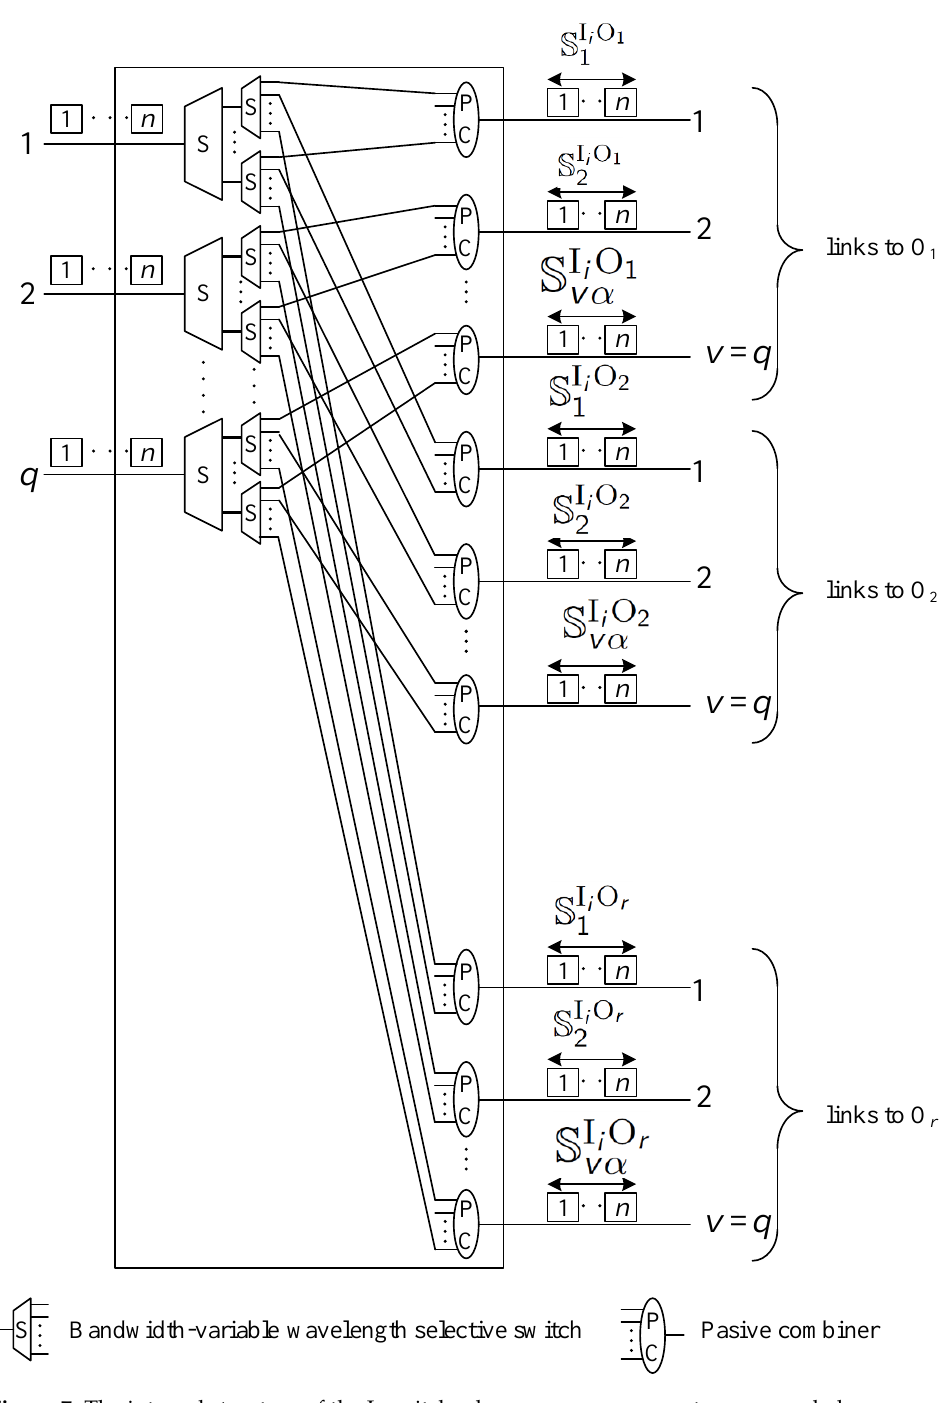
Figure 7. The internal structure of the I i switch when v = q —no converters are needed. Table 2. The number of TCs and FCs in various CC ( q , r , v , n , k ) switching fabrics with m max = n